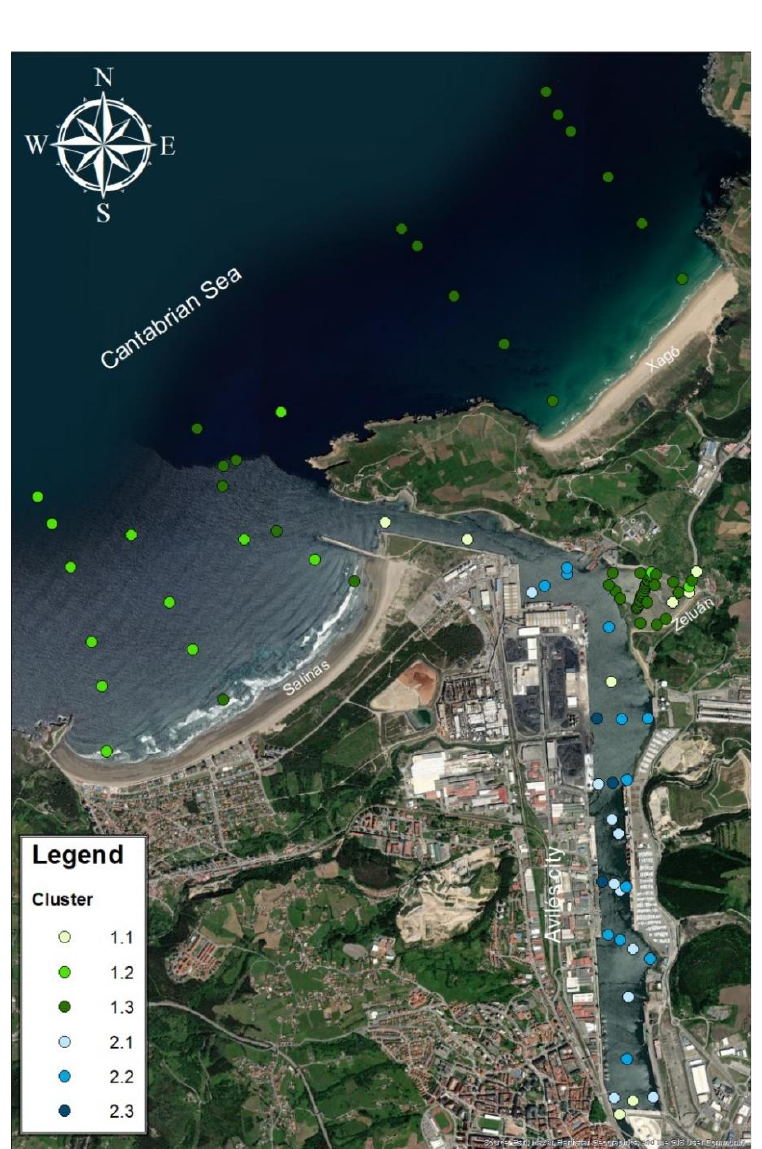
Figure 4. Geographical representation of the cluster hierarchy analysis results.